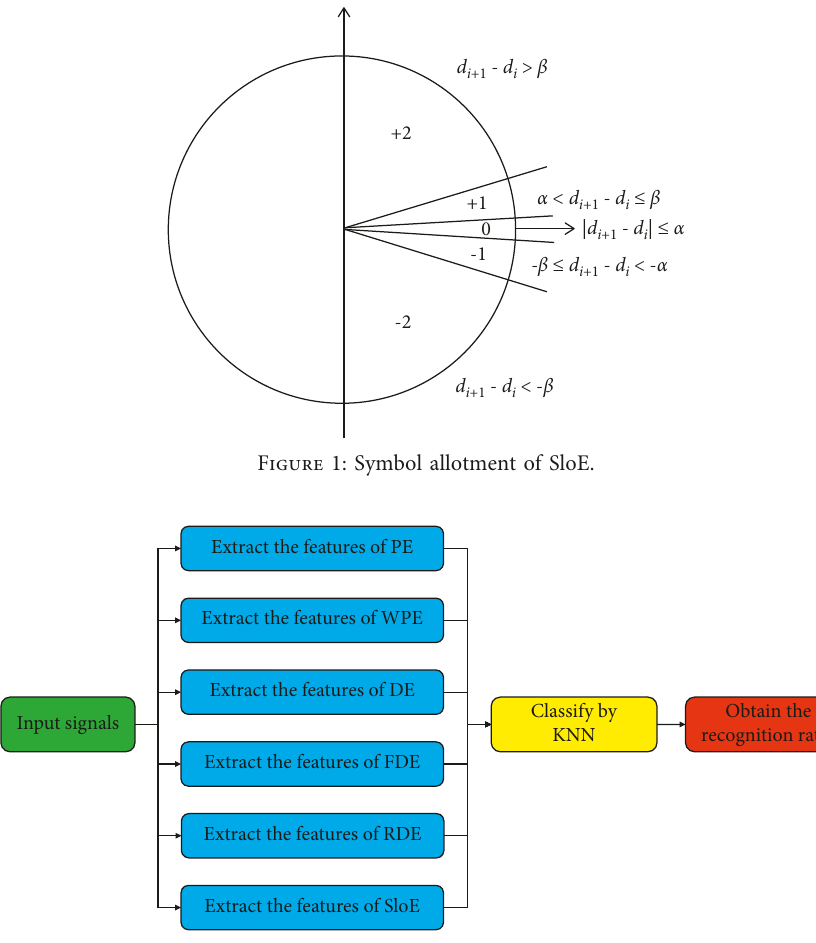
Figure 2: The flow chart of the single feature extraction